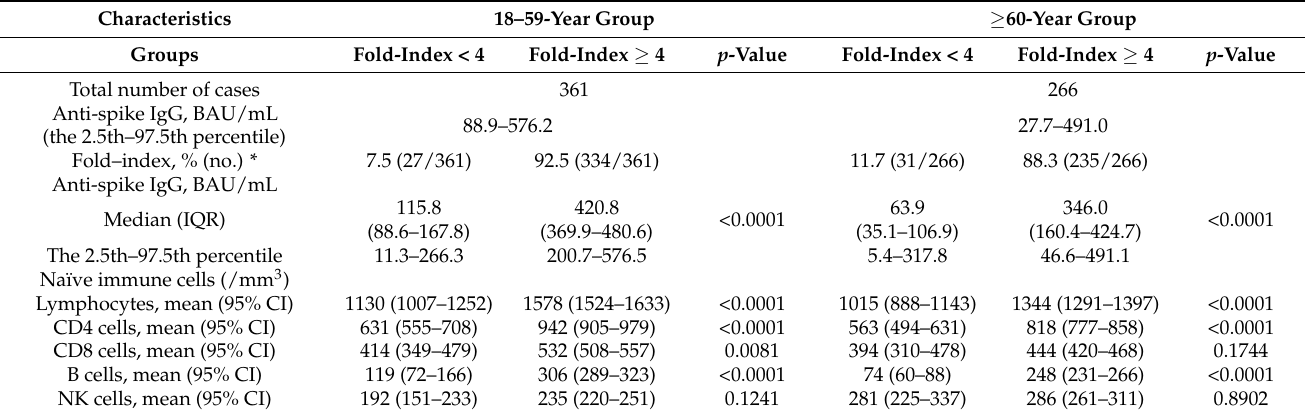
Table 2. Characteristics of immunity before and after the complete vaccination.